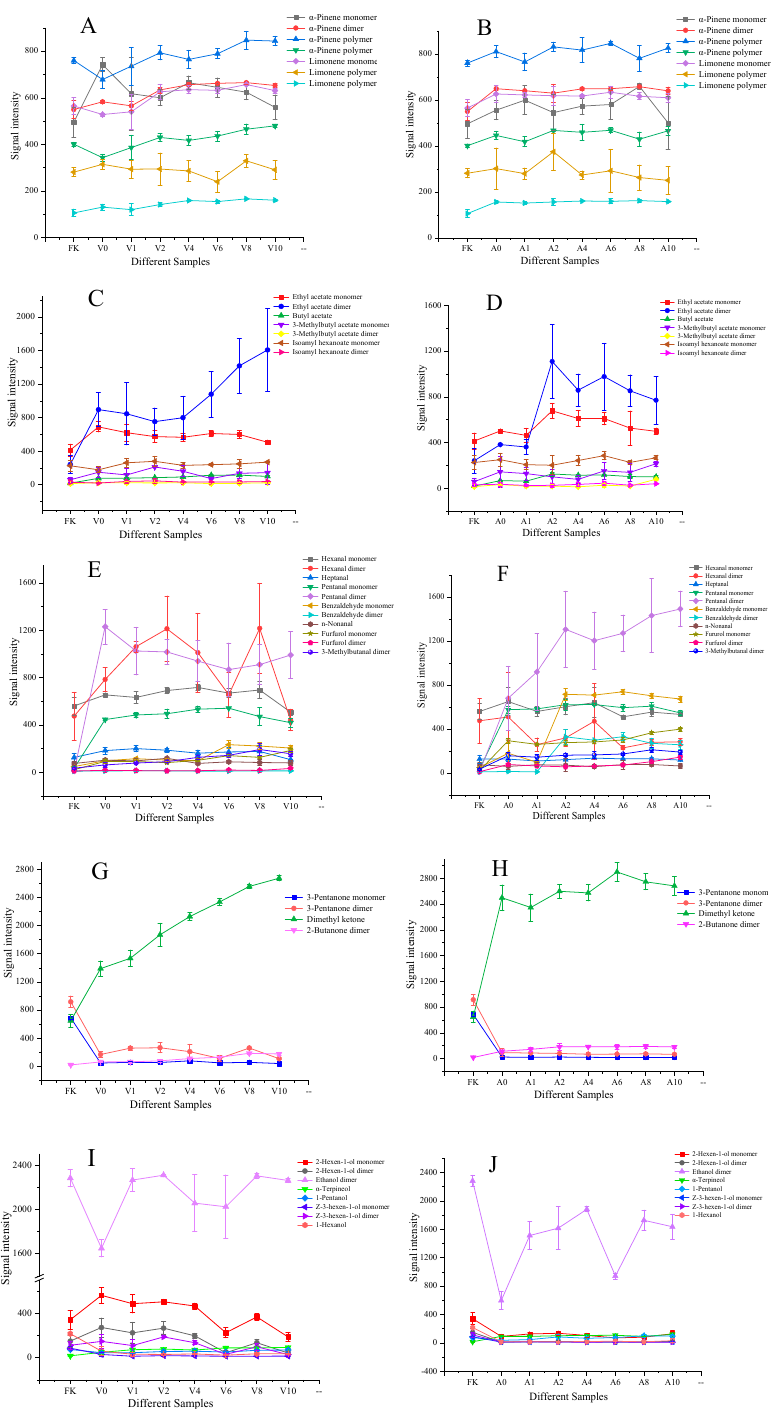
Figure 6. Line graph showing the intensity (mean ± standard deviation) of markers identified in the kumquat samples. Note: FK: FK; V0: VS-ADKs for 0 h; V1: VS-ADKs for 1 h; V2: VS-ADKs for 2 h; V4: VS-ADKs for 4 h; V6: VS-ADKs for 6 h; V8: VS-ADKs for 8 h; V10: VS-ADKs for 10 h. A0: AS-ADKs for 0 h; A1: AS-ADKs for 1 h; A2: AS-ADKs for 2 h; A4: AS-ADKs for 4 h; A6: AS-ADKs for 6 h; A8: AS-ADKs for 8 h; and A10: AS-ADKs for 10 h. ( A , B ) Two types of terpenes of FKs, VS-ADKs, and AS-ADKs; ( C , D ) Four types of esters of FKs, VS-ADKs, and AS-ADKs are shown; ( E , F ) Seven types of aldehydes of FKs, VS-ADKs, and AS-ADKs; ( G , H ) Three types of ketones of FKs, VS-ADKs, and AS-ADKs; Six types of alcohols of FKs, ( I , J ) VS-ADKs and